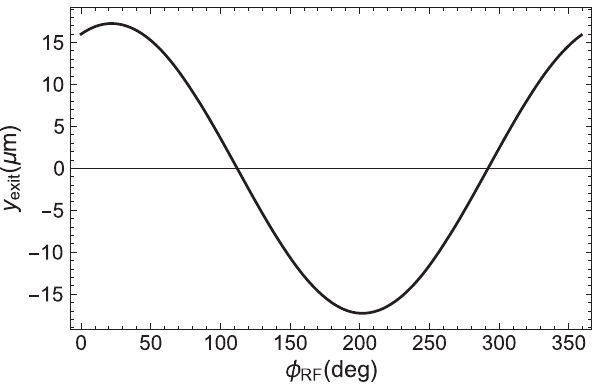
[31].FIG. 30. Beam drift at the exit of the undulator versus rf injection phase, adapted from Toufexis et al.